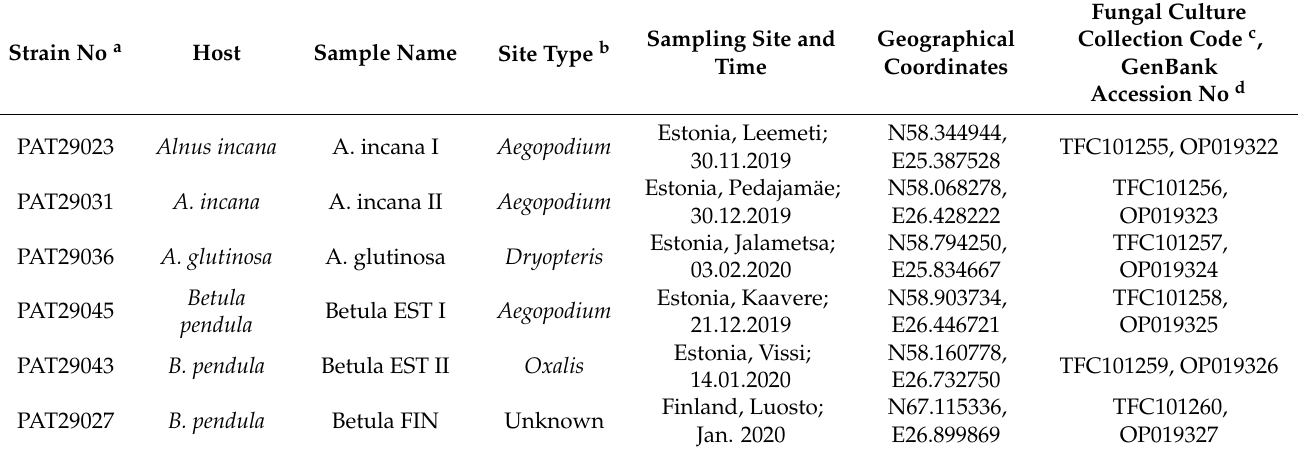
Table 1. Origin and hosts of Inonotus obliquus , isolated from the conks and used in this study’s fungal